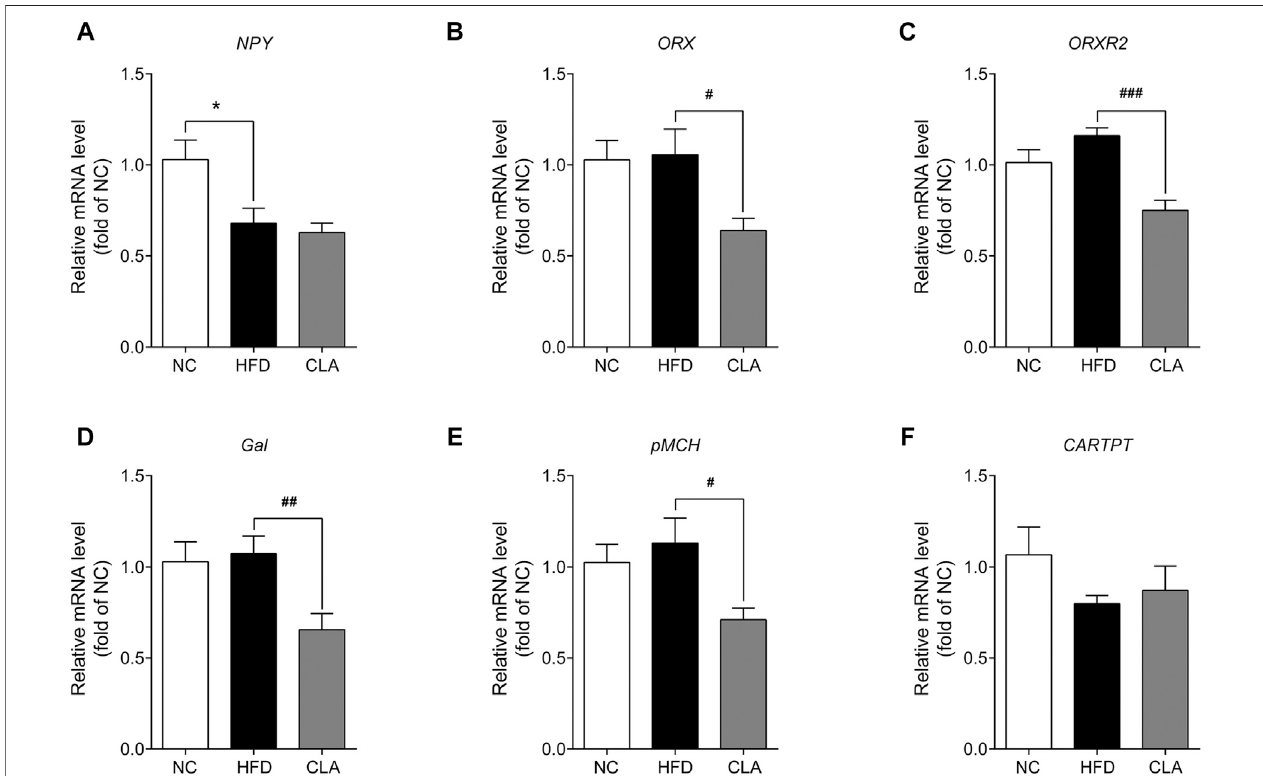
FIGURE3| EffectofCLAontheappetite-relatedgenesinthehypothalamusofmicegivenaHFD.Miceweresacri fi ced,andtheirhypothalamicwereisolatedatthe end ofthe experiment forRT-qPCR analysisof theappetite-related genes. (A – F) Hypothalamic mRNA levels of NPY , ORX , ORXR2 , Gal , pMCH , and CARTPT relative to β -actin were measured by qPCR. Data are shown as the mean ± SEM ( n (cid:2) 6). * p < 0.05 vs. NC. # p < 0.05, ## p < 0.01, ### p < 0.001 vs. HFD.